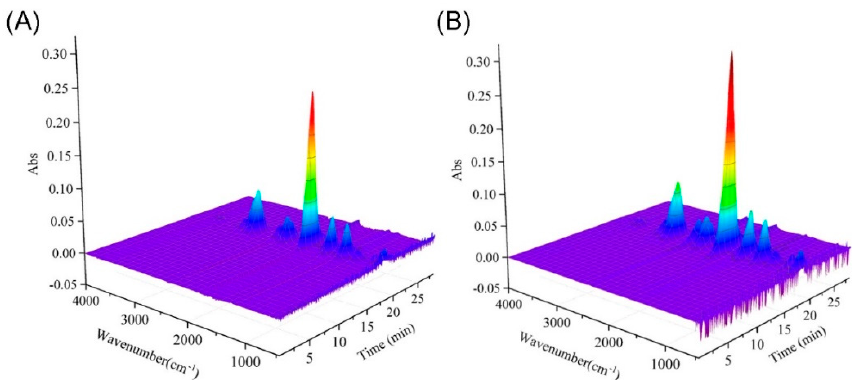
Figure 11. Raman spectra of the char residues of PLA and its flame retardant composites.